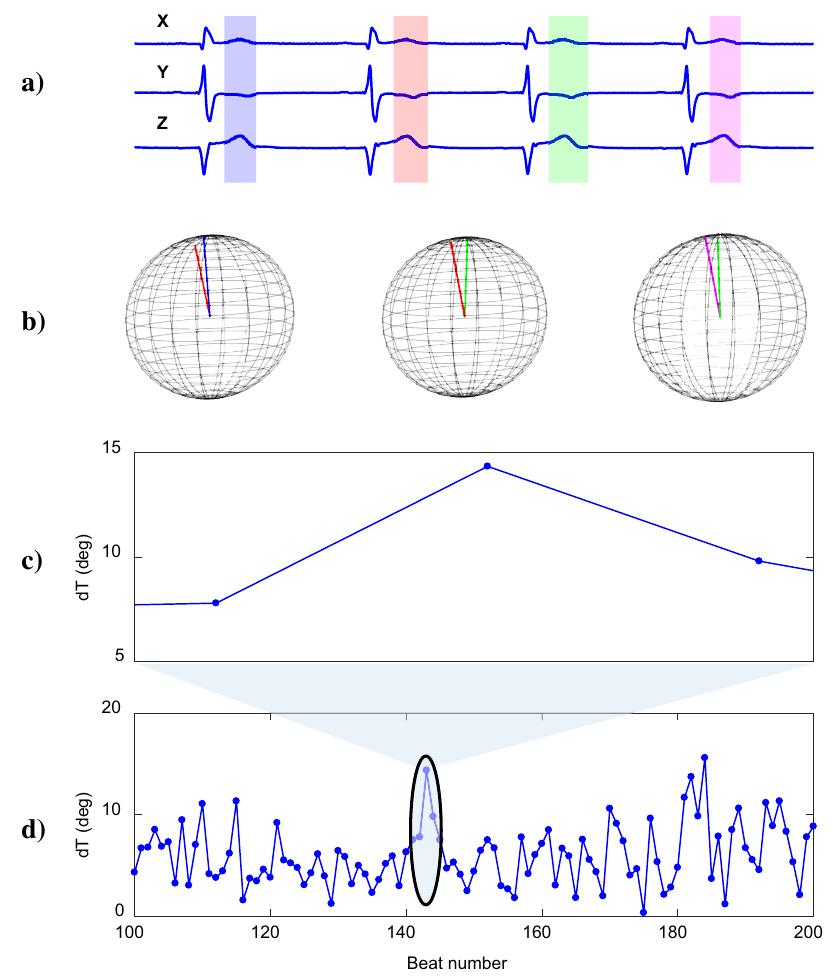
Figure 7. Illustration of steps for PRD calculation from ECG recording in Frank lead configuration ( a ) T-waves for four consecutive beats. ( b ) Three-dimensional visualization of each pair of T-wave vector. ( c , d ) Angle between two consecutive T-wave vectors, dT ◦ , along 100 beats.